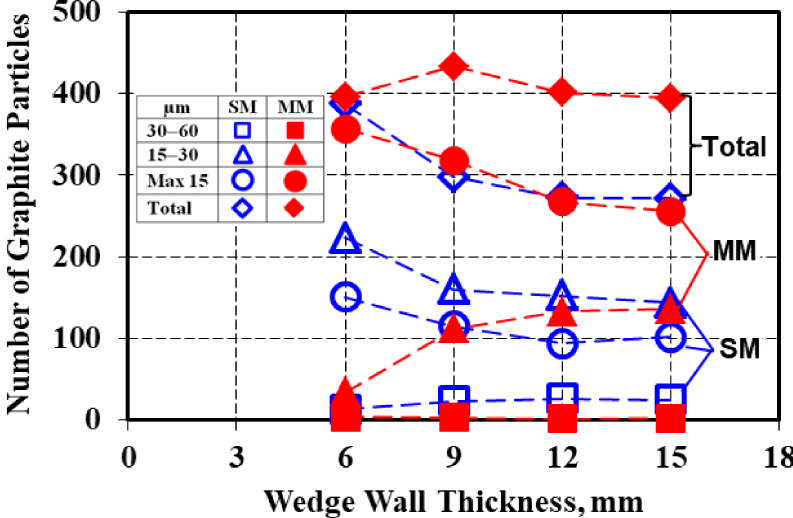
Figure 4. Influence of the mold media type and wedge casting wall thickness on the graphite